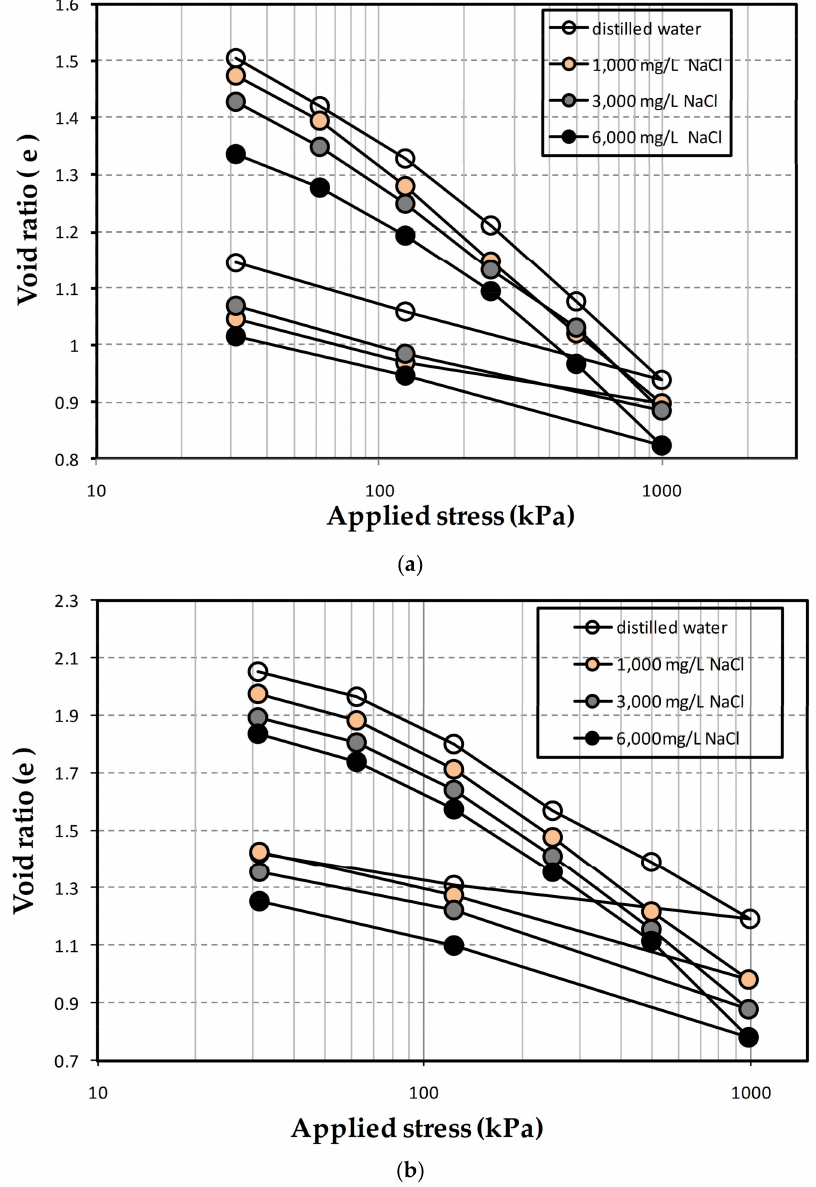
Figure 9. Compression curves: ( a ) Semarang clay; ( b )Demak